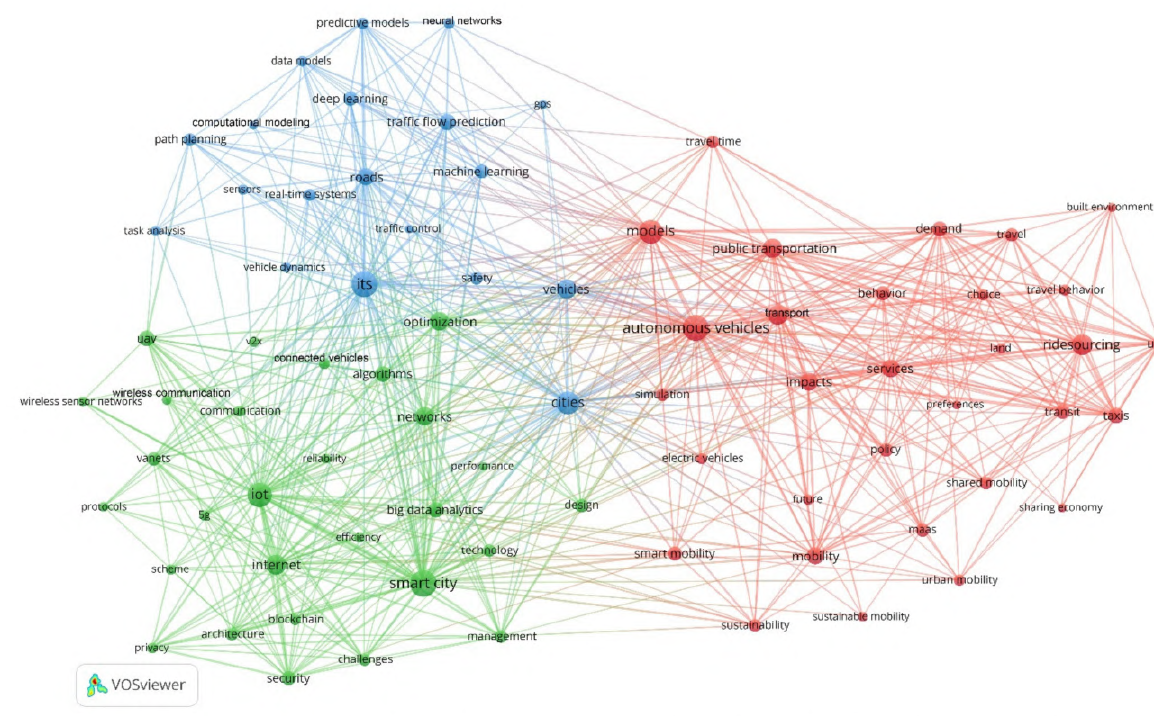
Figure 11. Mapping Keywords Output from 2020 to 2021. Illustration by